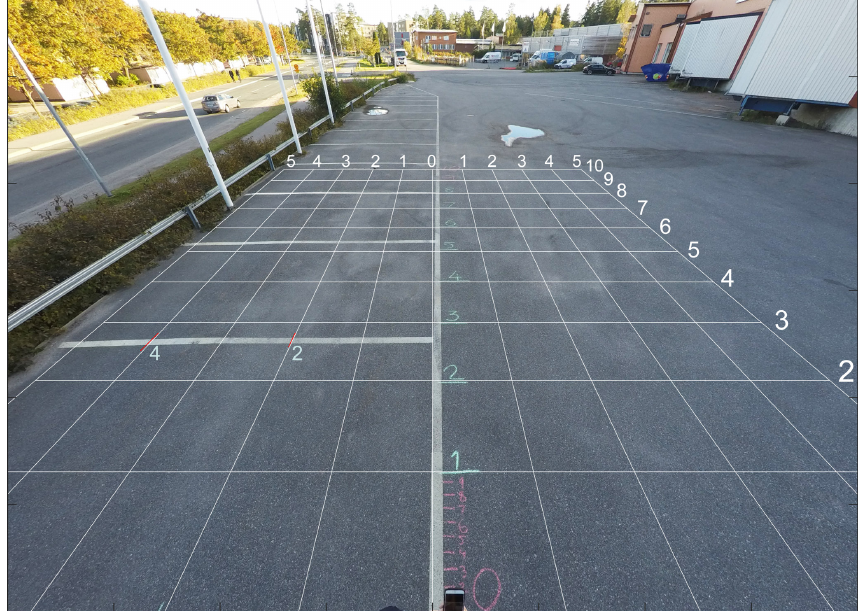
Figure 5. Calibration of projected geometry using an image corrected for lens distortion. Model geometry is shown as white numbers and a white grid, while green and red numbers are written on the ground using chalk (red lines at 2 and 4m left of the center line were strengthened for clarity). The camera height in this calibration measurement is